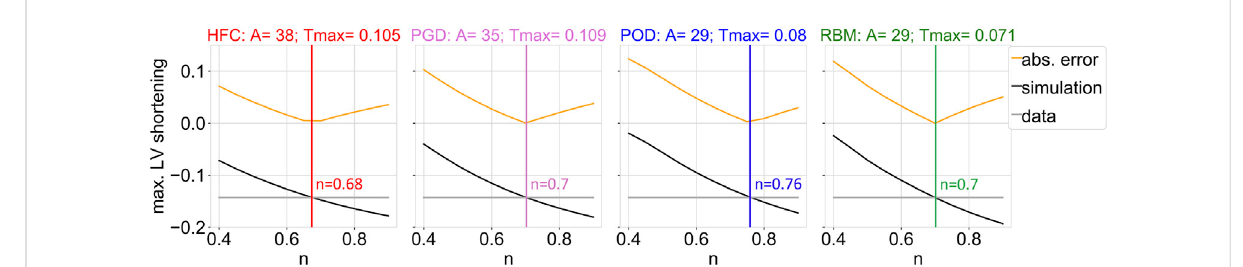
FIGURE 4 Objective function (yellow) of the fi tting procedure of the parameter that scales the active contribution in sheet direction (n), which is given by the difference between data and simulation outcome of the maximum of the left ventricular shortening during the cardiac cycle with respect to the initial con fi guration in diastasis. The maximum of the left ventricular shortening as a function of the parameter n is shown, for the data (gray) and the simulation output (black), together with their absolute difference (yellow). The optimized parameter value resulting in the smallest absolute shortening error is indicated by the vertical line. Each subplot shows the results of the parameter estimation for one interpolated fi ber fi eld obtained by the four compared methods: HFC, PGD, POD, and RBM. The subtitles indicate the previously adjusted parameter values of the passive (A) and active ( T max [ MPa ]) scaling factors.